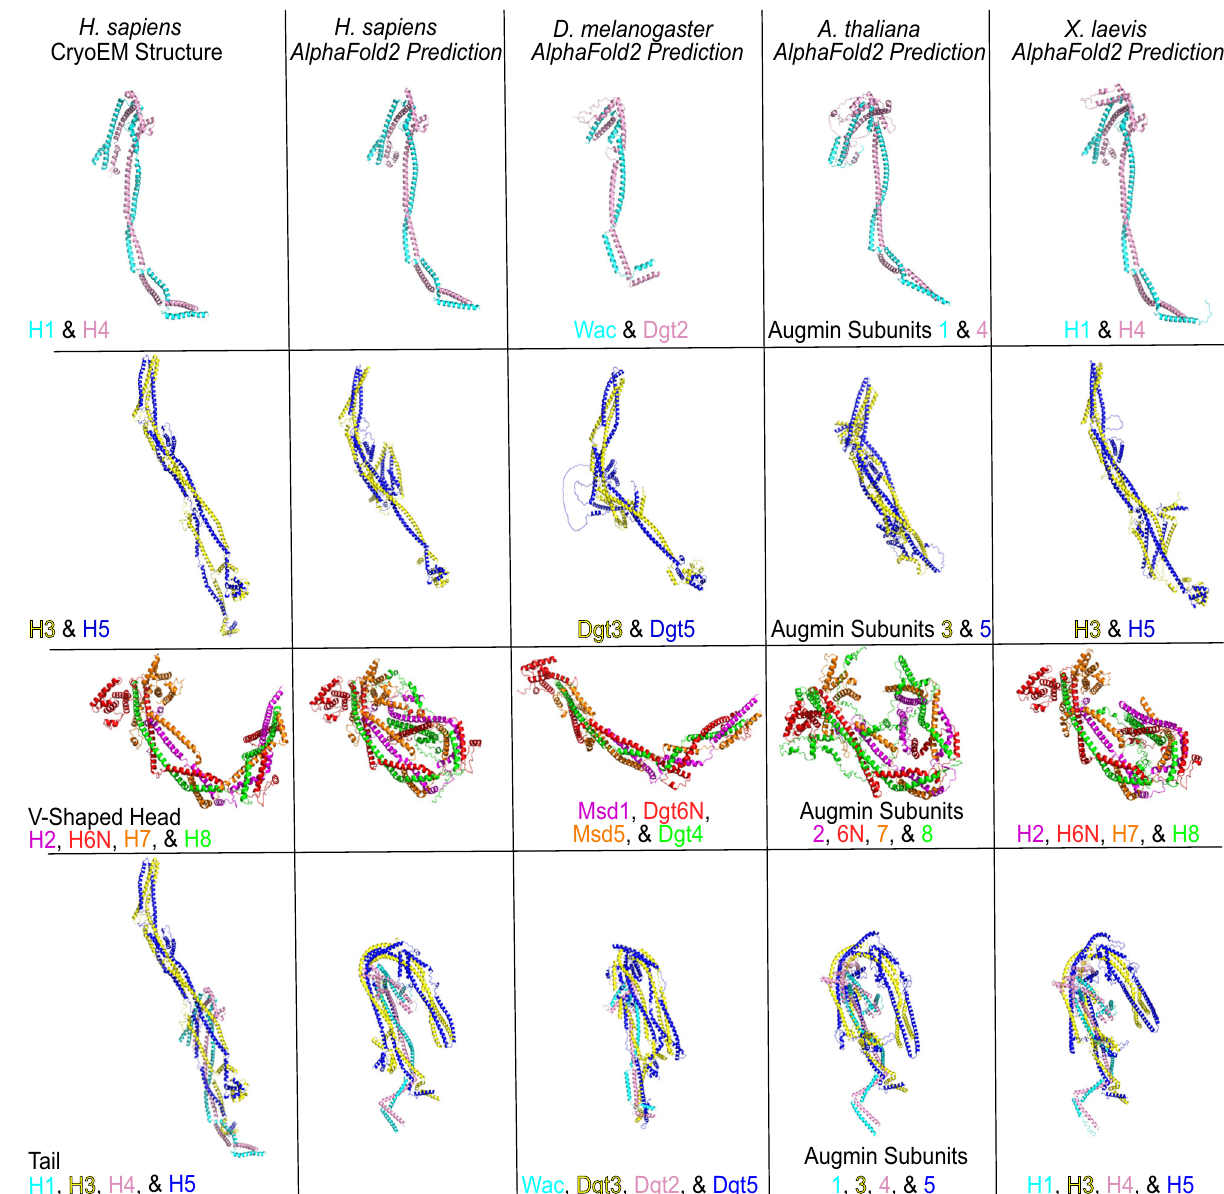
Fig. 6 | Cross-species comparisons of the augmin complex predicted by AlphaFold2. Comparisons ofthe H1/4 and H3/5 dimers, V-shapedhead,and tail of augmin across H. sapiens, D. melanogaster, A. thaliana , and X. laevis . Cryo-EM